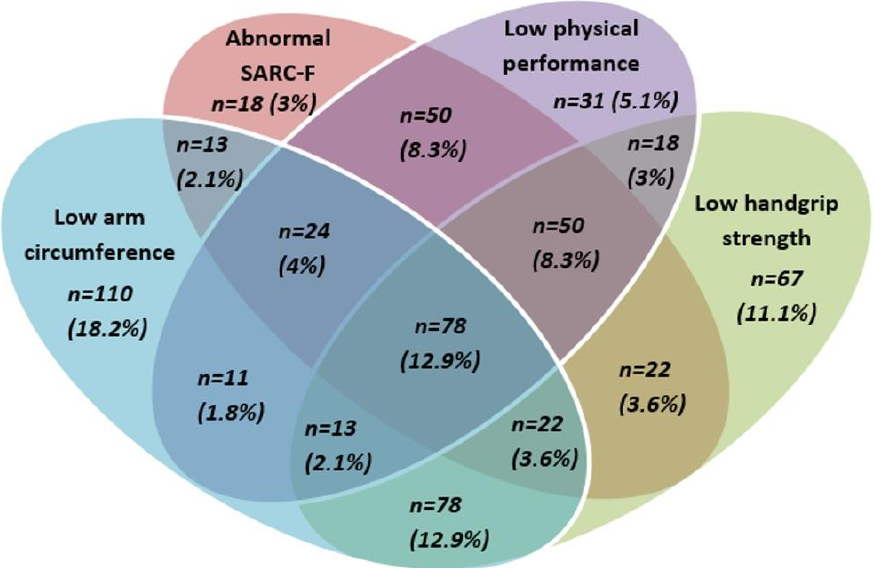
Figure 1. Overlap between four criteria for probable sarcopenia in older patients with cancer ( n =